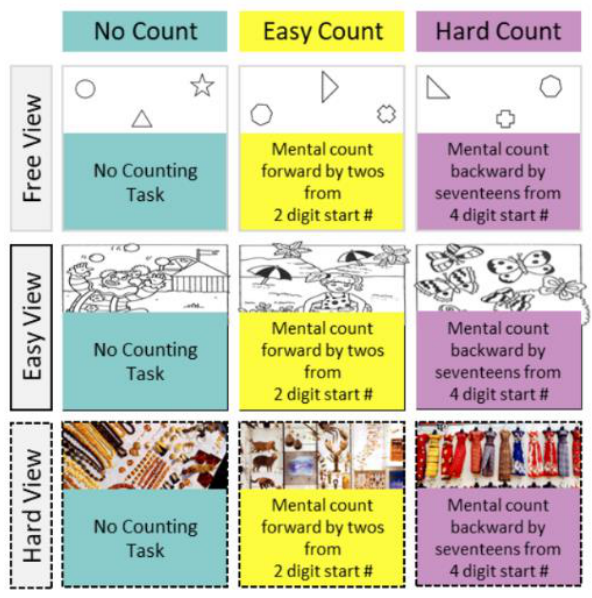
Figure 2. Three levels of difficulty in visual and cognitive tasks resulted in a total of nine conditions presented in the experimental portion of the